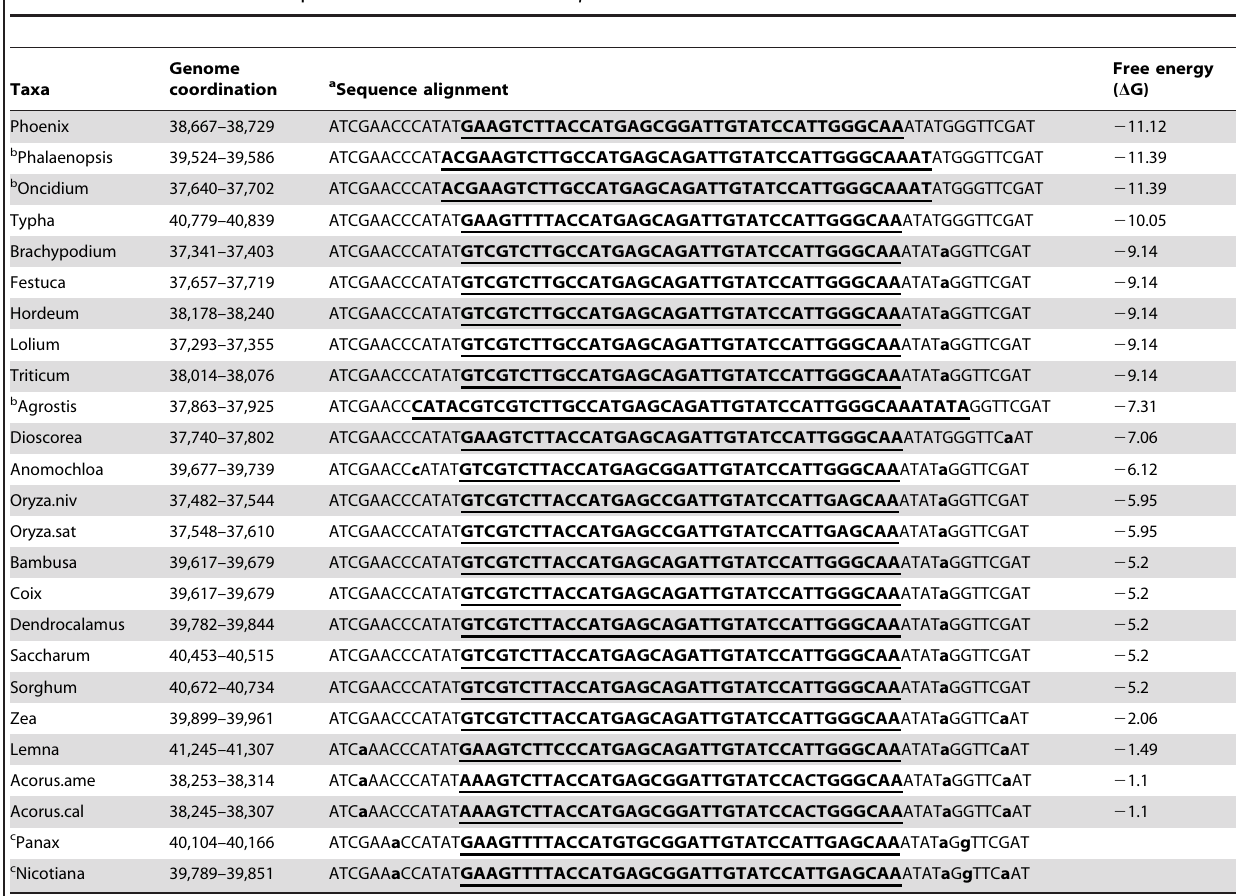
Table 3. The location and sequences of small inversion in psaB